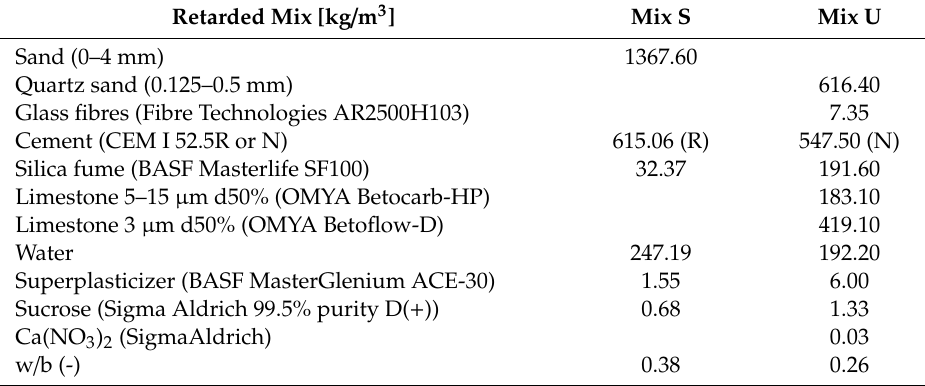
Table 1. Mix designs used in mix S and U prior to acceleration.